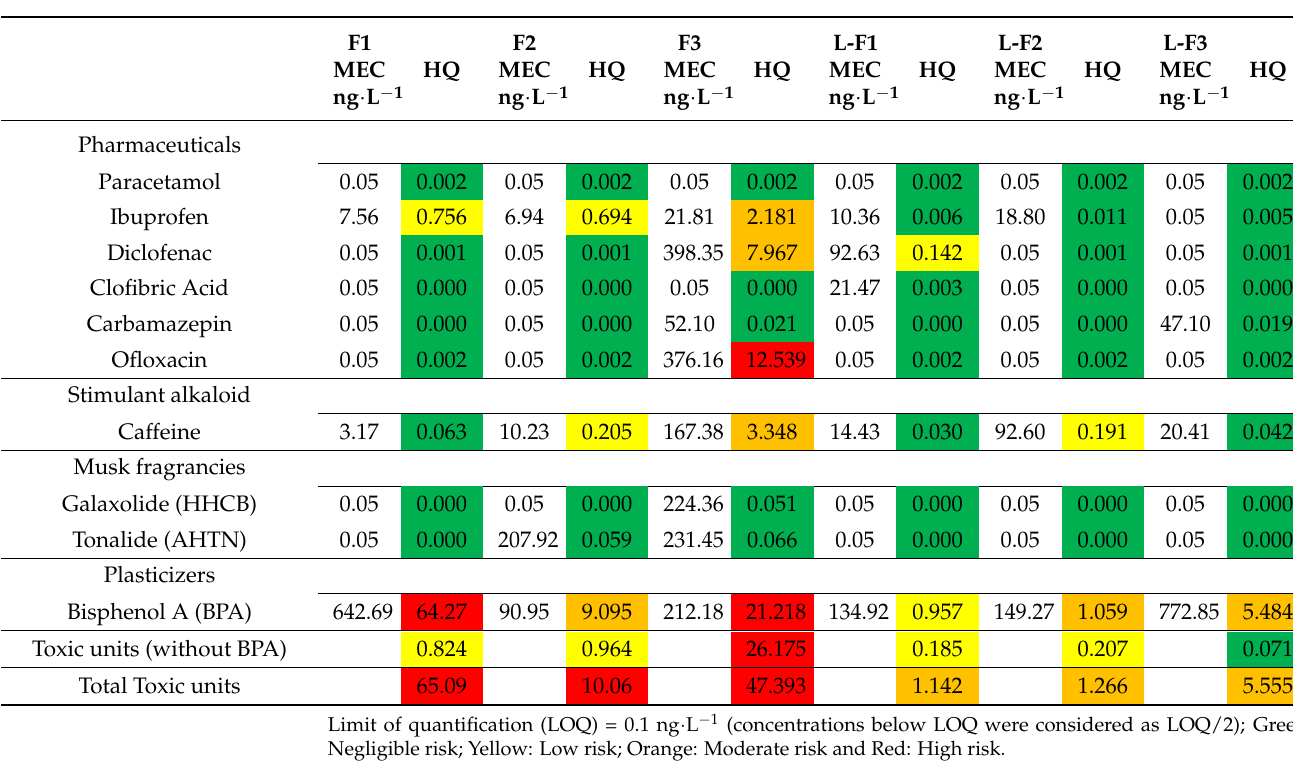
Table 2. Measured mean environmental concentrations (MEC) and Hazard Quotient (HQ) for CECs dissolved in water and lixiviates from sediments in F1, F2, and F3.